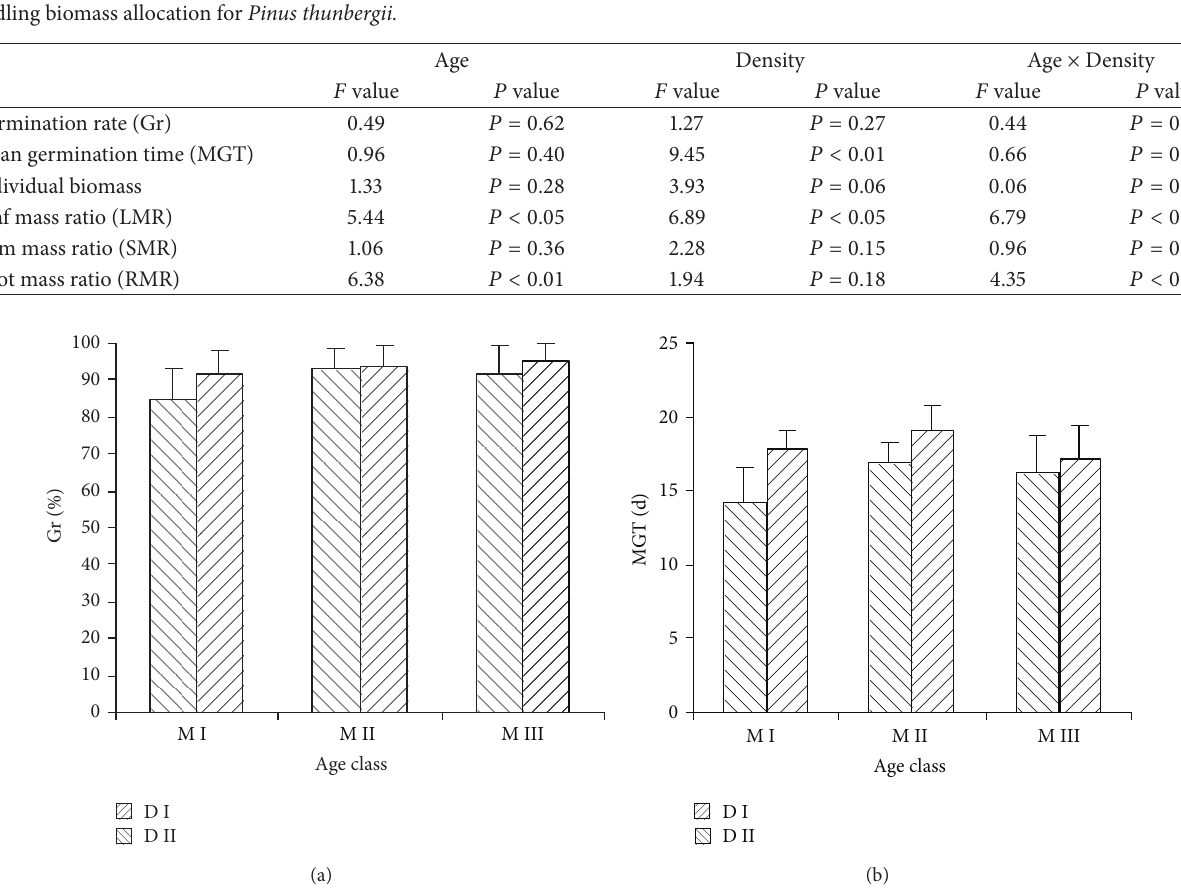
Figure 1: Effects of age and stand density of mother tree on seed